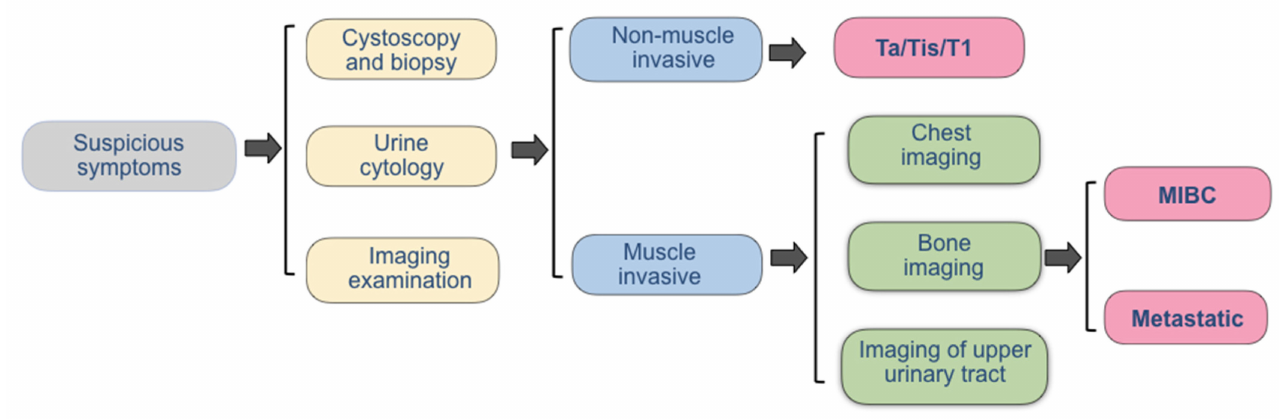
Figure 2. Current strategies for the diagnosis of bladder